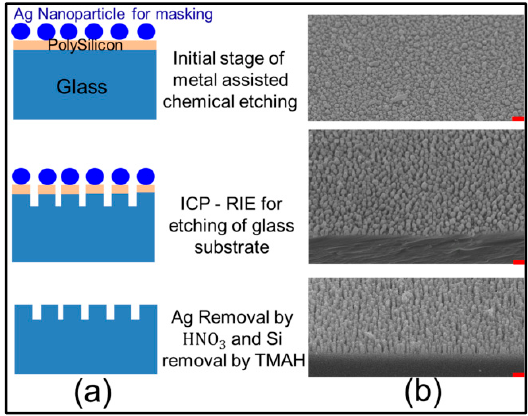
Figure 1. ( a ) Complete process for nanostructure formation; ( b ) SEM image for masking and dry etching process of glass nanostructure (all scale bars represent 500 nm).